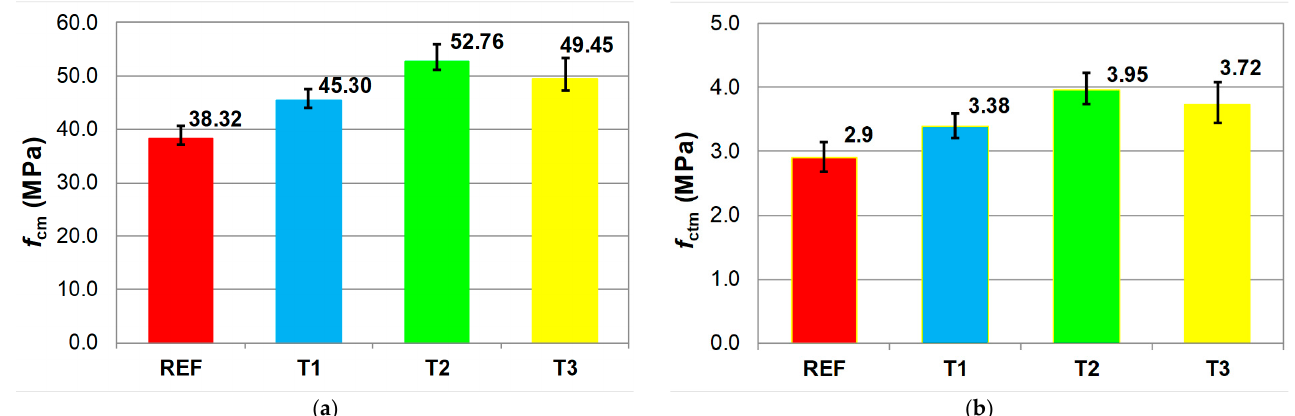
Figure 4. Results of compressive strength ( a ) and splitting tensile strength ( b ) of analyzed concretes. Based on the obtained test results, it should be stated that the highest compressive and splitting tensile strength was obtained for concretes containing the addition of two different SCMs in the composition of the cement matrix, i.e., T2 and T3. The increases in both strength parameters